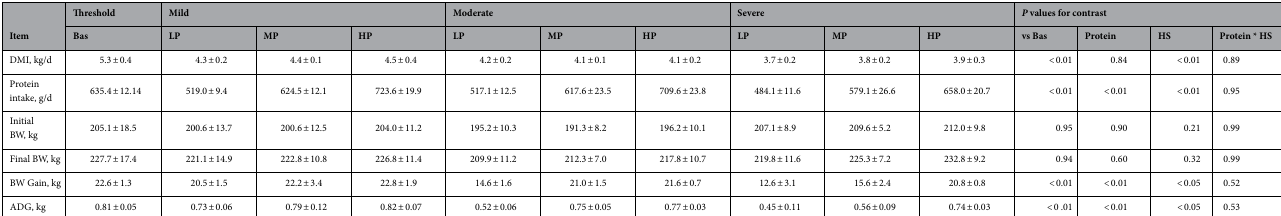
Table 5. Effects of dietary protein levels on DMI, protein intake, and growth performance in Korean native beef calves under heat stress. vs Bas = Control (with 12.5% dietary protein levels, THI 68 to 70) vs 9 experimental diets (with 3 dietary protein levels, with 3 THI levels). THI = Temperature humidity index, THI = (1.8 × Tdb + 32) – [(0.55 – 0.0055 × RH) × (1.8 × Tdb − 26.8). Threshold = THI 70 to 73, Mild = THI 74 to 76, Moderate = THI 81 to 83, Severe = THI 89 to 91. LP = Low protein (12.5%), MP = Medium protein (15%), HP = High protein (17.5%). The data are presented as the means ± standards error (n = 4/group).